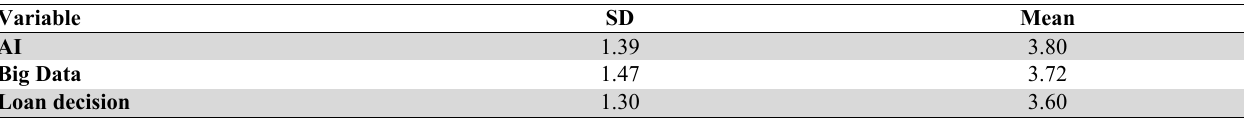
Means and Standard Deviation Variable SD Mean AI 1.39 Big Data 1.47 Loan decision 1.30 3.60